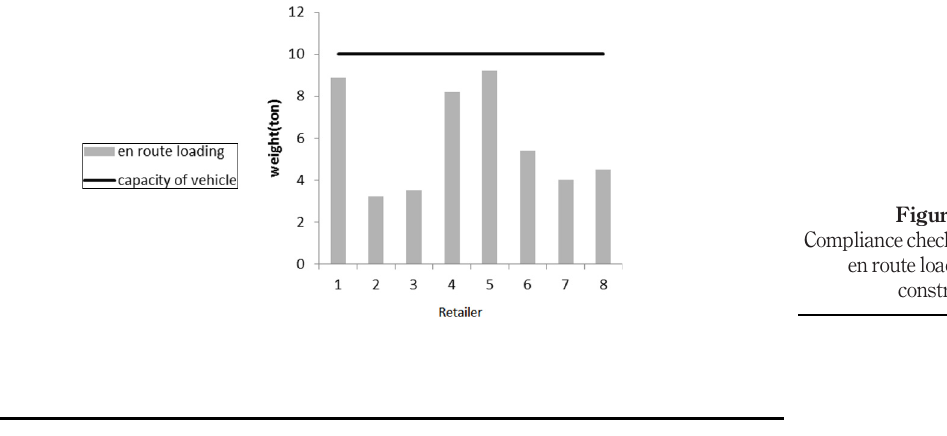
Table 3. Comparison of the